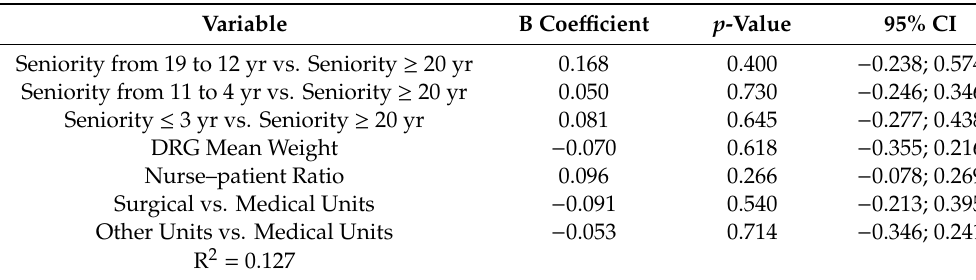
Table 3. Percentage of cases with the assessment of pain.